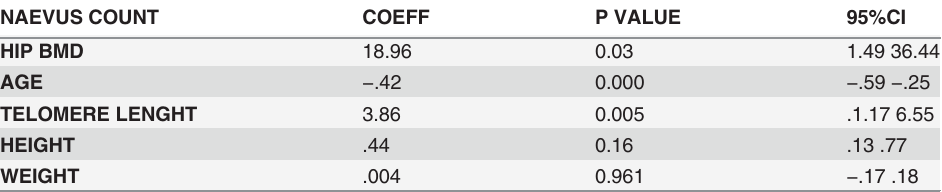
Table 3. Multivariate Linear Regression for the association between naevus counts and hip BMD. (Robust regression) (n = 2119).